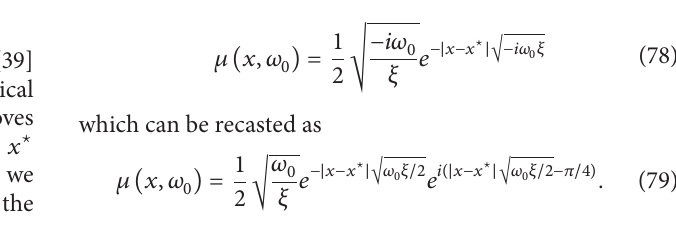
Figure 1: (Color online) Time periodic force 𝐹 0 cos (𝜔 0 𝑡) . (a) 3D rendering of a membrane described by (1), under the effect of an applied time periodic force in ⃗𝑥 ⋆ (black arrow). ℎ( ⃗𝑥,𝑡) represents the height of the fluctuating membrane on a 2-dimensional substrate ( ⃗𝑥 = (𝑥,𝑦) ). Regions I and II correspond, respectively, to the inner and outer region in which the membrane separates when the force is applied. The color code, red for region I and green for region II, has been drawn for the reader’s convenience: increasing the frequency 𝜔 0 entails the shrinkage of the red region (I). (b) Schematic representation of the untagged response amplitude |𝜇( ⃗𝑥, 𝜔 0 )| as a function of the distance | ⃗𝑥 − ⃗𝑥 ⋆ | : since it is a schematic drawing no scale is needed on the 𝑥 -axis. In region I the universal behaviour 𝜔 1−𝛽 hydrodynamic interactions. In region II the decay of the response’s amplitude is ∝ | ⃗𝑥 − ⃗𝑥 ⋆ | −𝛼 for long range hydrodynamic systems (grey (upper) solid line), ∝ | ⃗𝑥 − ⃗𝑥 ⋆ | −𝑧−𝑑 for local hydrodynamic systems with 𝑧 ̸= 2𝑚 with 𝑚 ∈ N (blue (middle) solid line), and exponentially fast for local hydrodynamic systems with 𝑧 = 2𝑚 (orange (bottom) line). (c) Schematic representation of the untagged response phase 𝜑( ⃗𝑥,𝜔 0 ) as a function of the distance | ⃗𝑥 − ⃗𝑥 ⋆ | . No scale is needed on the 𝑥 -axis. Region I: the system displays a universal phase delay for long range and local hydrodynamic interactions; that is, 𝜑( ⃗𝑥,𝜔 0 ) = (1 − 𝛽)(𝜋/2) . Region II: for long range hydrodynamic systems the phase is absent; that is, ) ≃ 0 (grey (middle) solid line); for local hydrodynamics the phase is approximately 𝜋/2 if 1 + 4𝑚 < 𝑧 < 3 + 4𝑚 with 𝑚 ∈ N (upper 𝜑( ⃗𝑥,𝜔 0 blue line), while it is approximately −𝜋/2 if 4𝑚 < 𝑧 < 1 + 4𝑚 or 3 + 4𝑚 < 𝑧 < 4 + 4𝑚 (bottom blue line); if the hydrodynamic interactions are local and 𝑧 = 2𝑚 the phase shows a linear dependence on the distance | ⃗𝑥 − ⃗𝑥 ⋆ | ; that is, 𝜑( ⃗𝑥,𝜔 0 ) ∼ −| ⃗𝑥 − ⃗𝑥 ⋆ | (orange (bright linear) solid